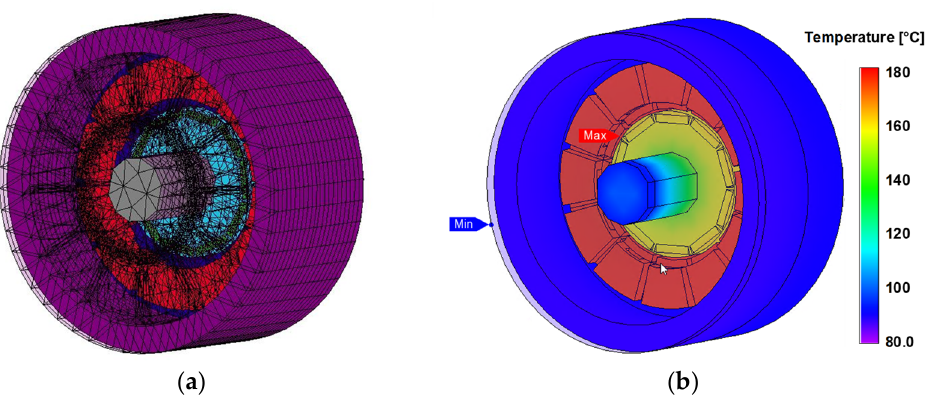
Figure 15. 3-D ETFEM model for a 12-slot/10-pole IPMSM. ( a ) 3-D FEM model (meshed view). ( b ) Steady-state temperature distributions. The front end-cap is modelled but removed for clarity.